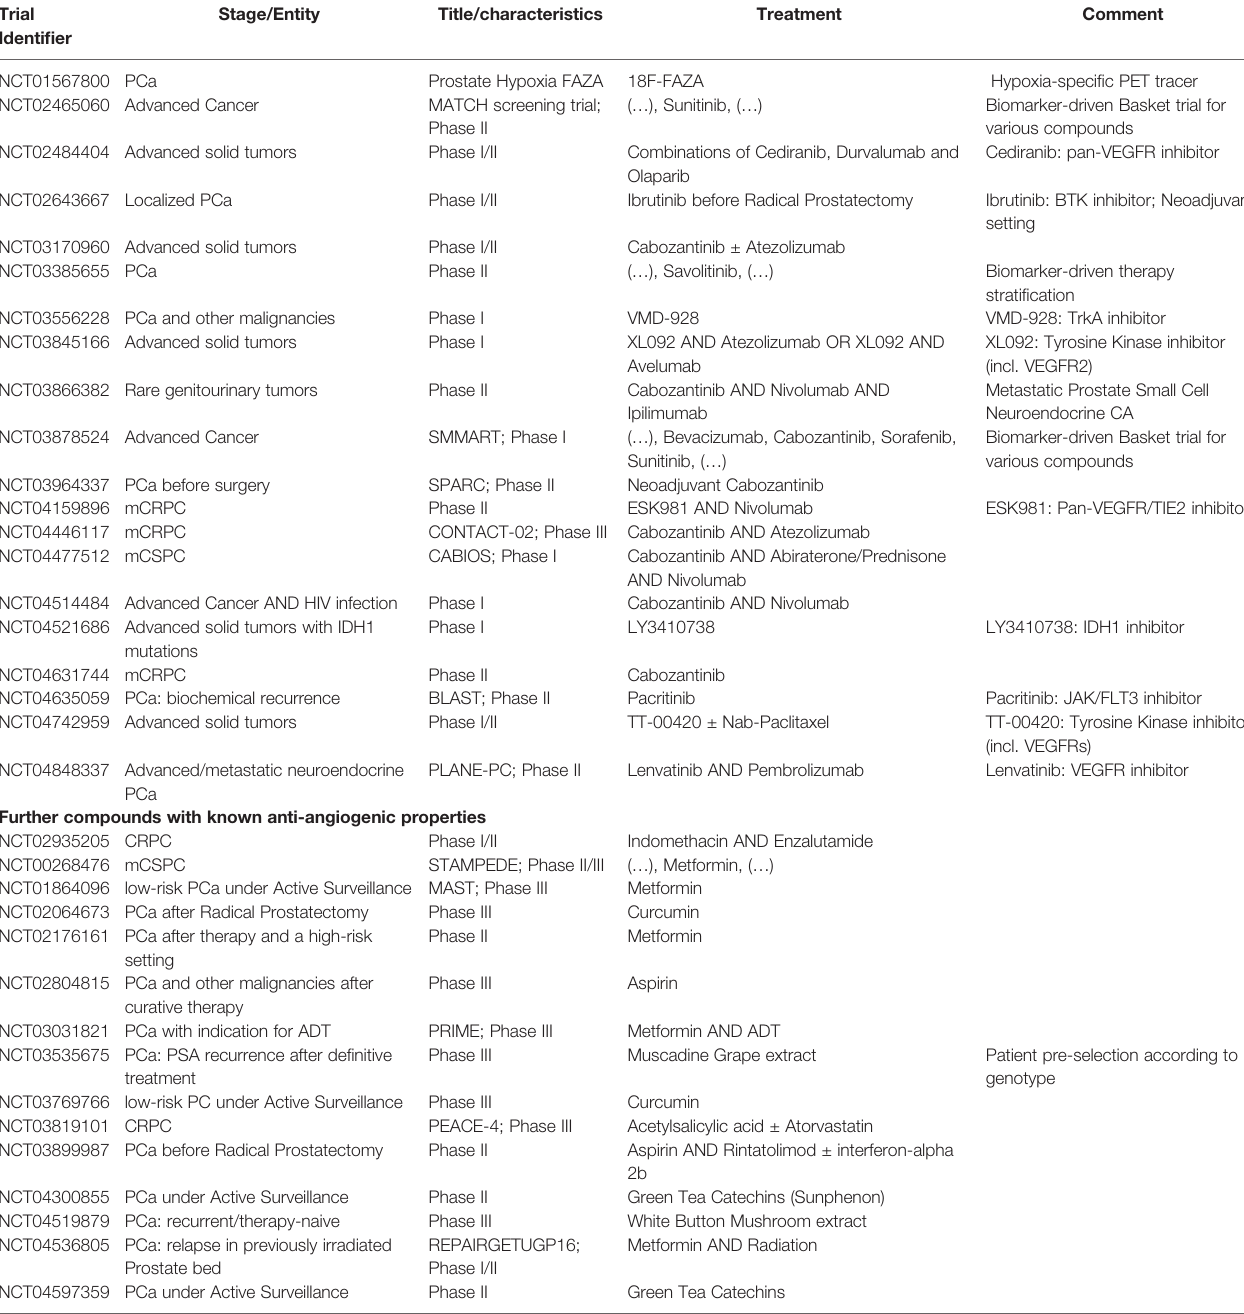
TABLE 1 | Recruiting interventional trials examining anti-angiogenesis in prostate cancer (PCa) registered within clinicaltrials.gov database (December